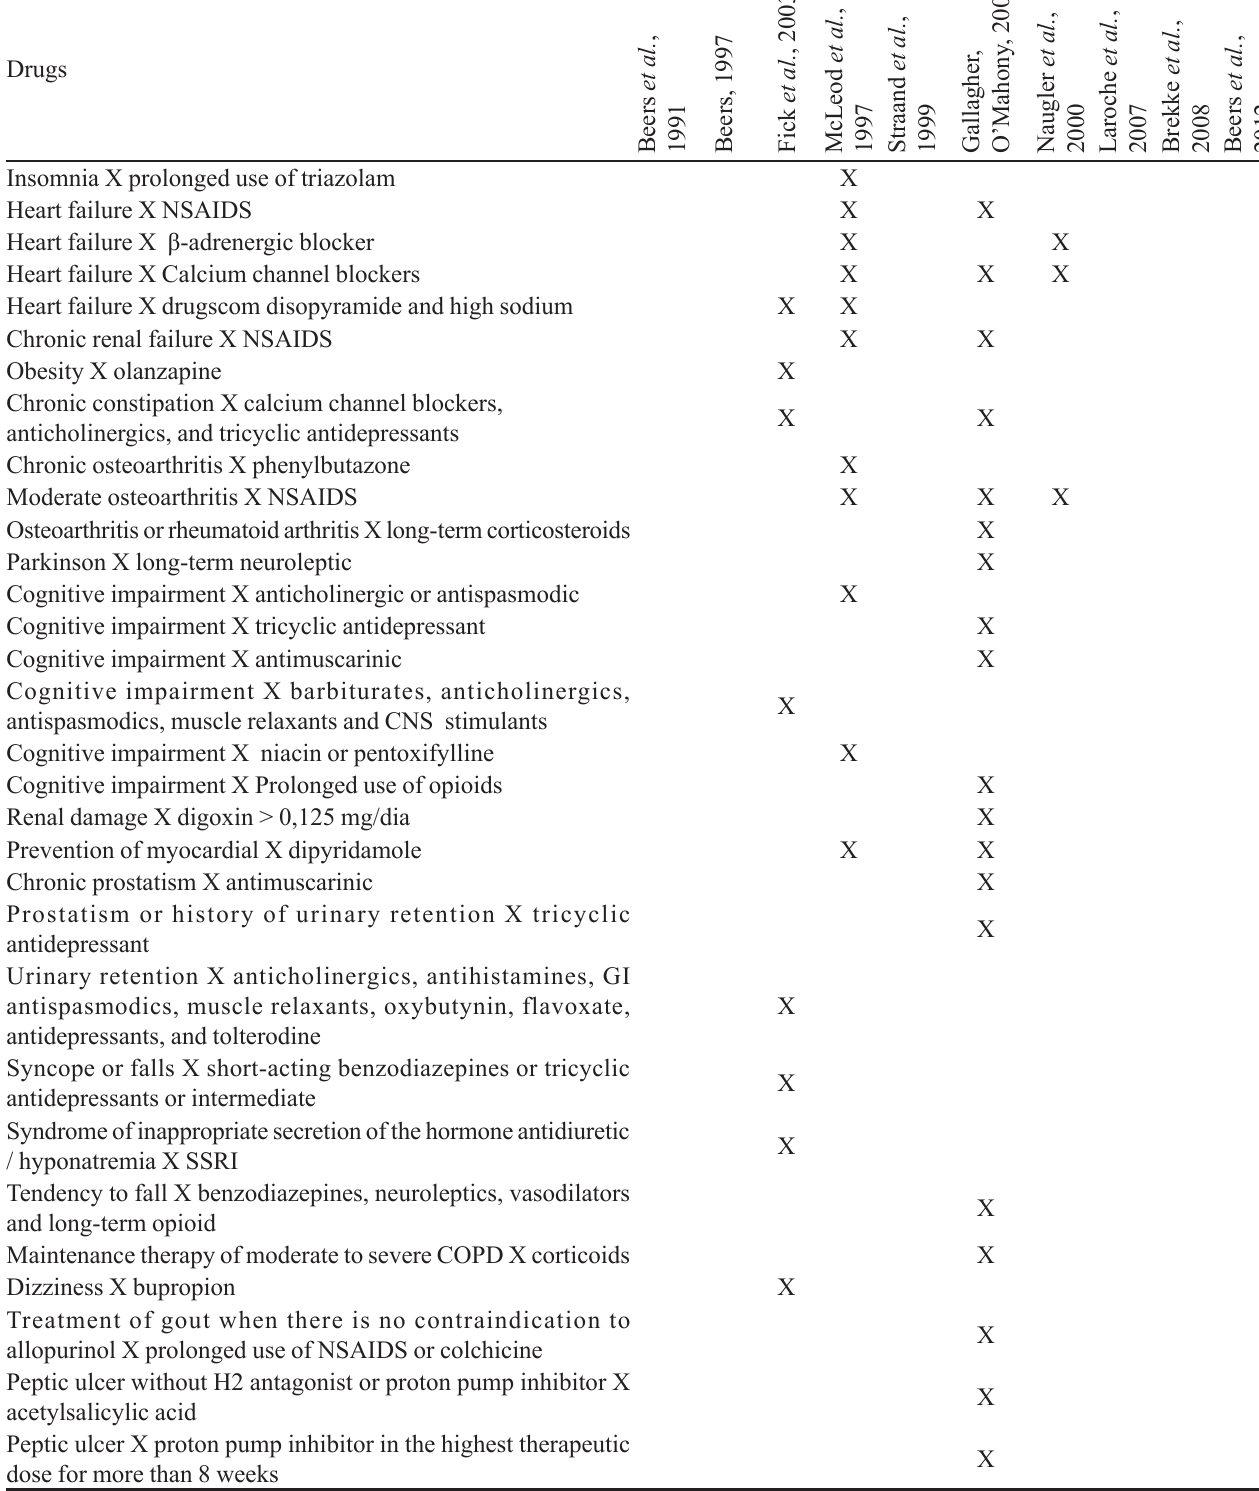
TABLE IV - List of potentially inappropriate medications (PIM) for the elderly that should be avoided as indicated by the clinical diagnosis of the patient (drug interaction with disease), the dose, frequency and duration of the drug administration and drug association, according to the methods identified in PAHO (available at: http://regional.bvsalud.org/php/index.php), Lilacs and Pubmed databases, during the period between February and March 2010 (n=9)